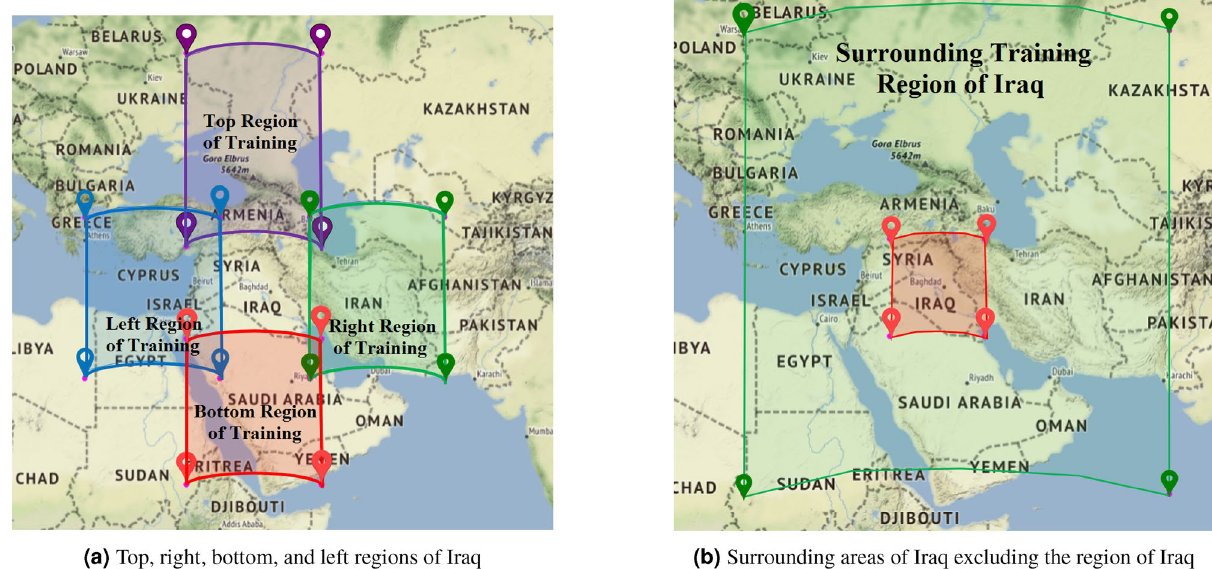
Figure 2. Regions that are considered in preparing training datasets (the figures are created using Python 3.8 43 and Microsoft Power Point 44